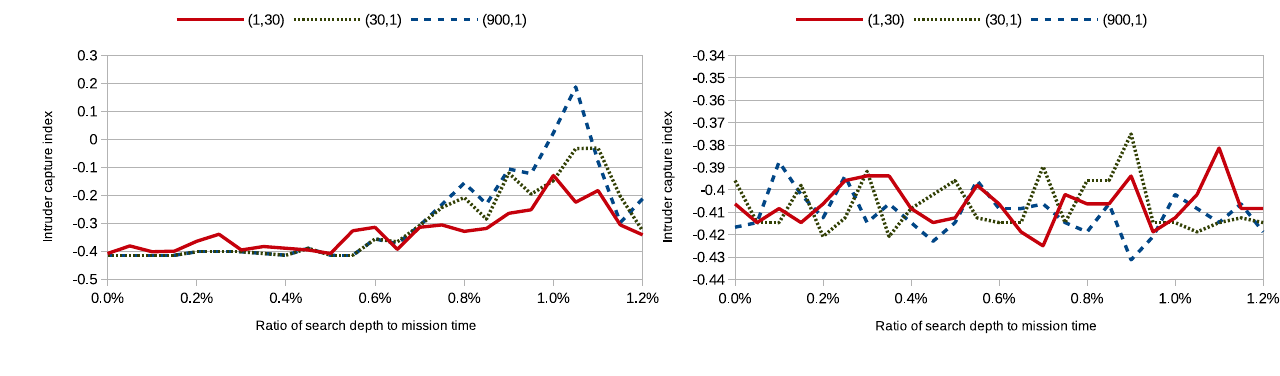
Figure 3. Intruder capture index for Scenario A2 using uavsAction () ( left ) and localSearch () ( right ).